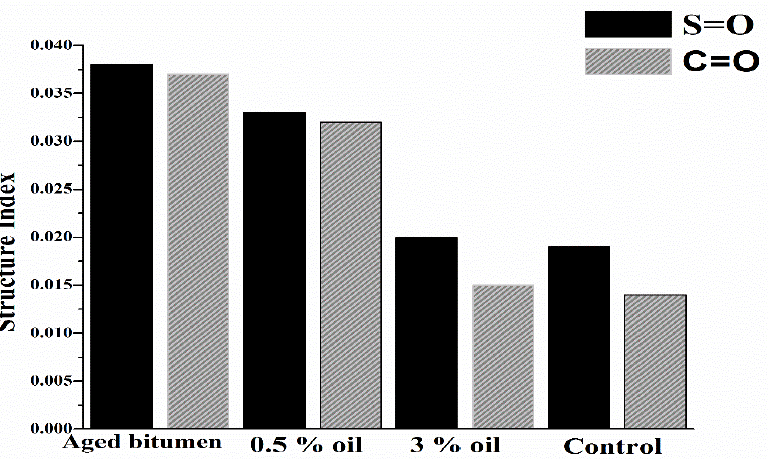
Figure 11. FTIR Structural Indices.